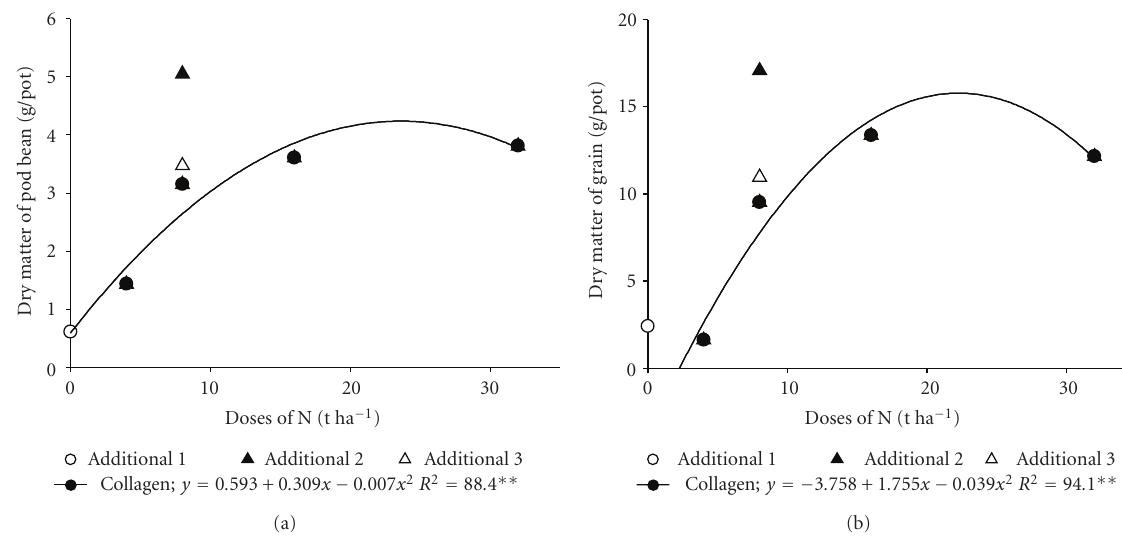
Figure 2: Production of pod dry matter of bean plants (a) and production of grain dry matter of bean plants (b) grown for 84 days, under influence of the studied treatments (collagen: four rates; additional 1: soil without fertilization and without collagen; additional 2: fertilization with mineral N; additional 3: wet blue residue).